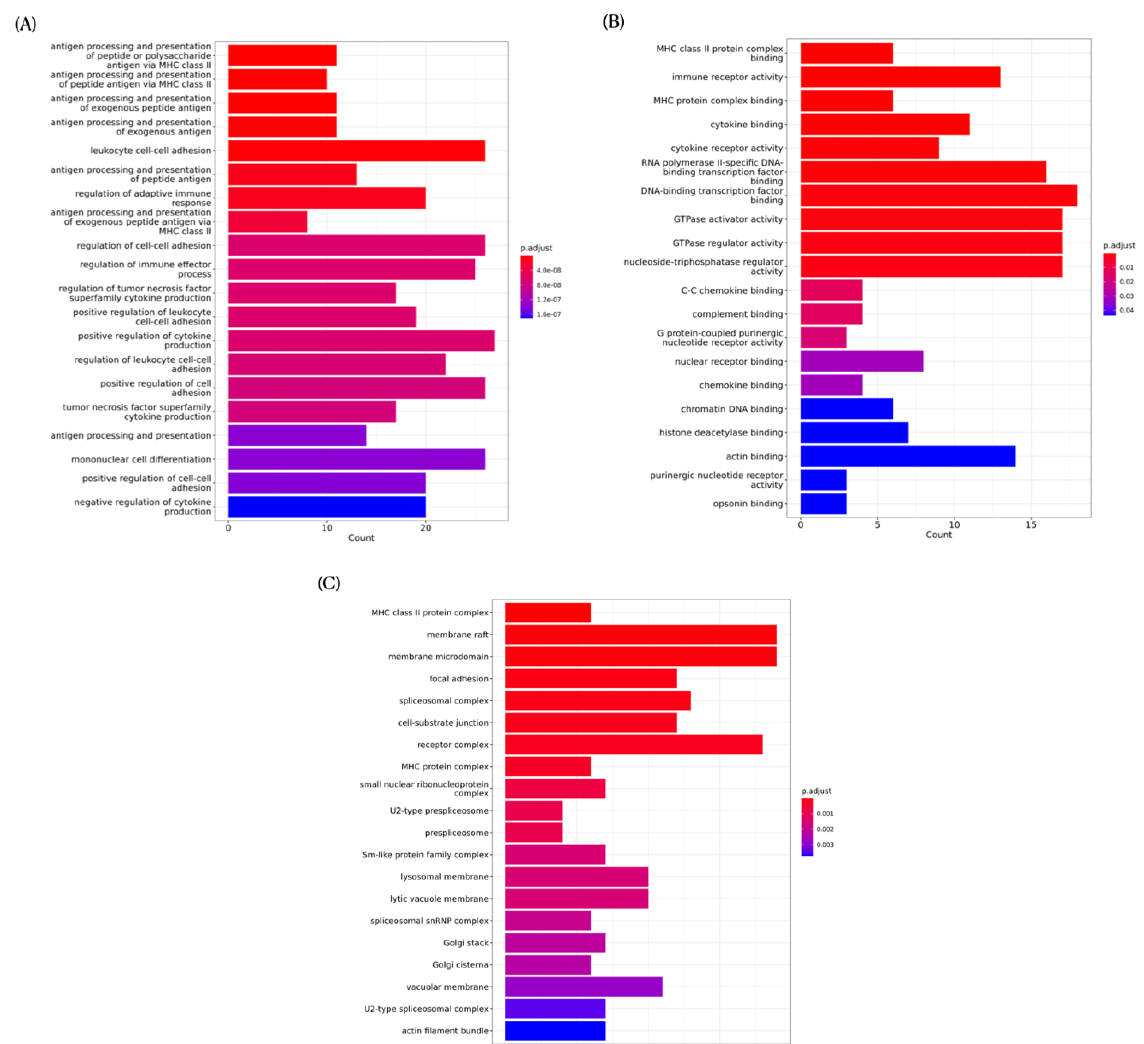
Figure 9. Gene ontology (GO) analysis of EX + RES150 group vs. NC group. ( A ) GO analysis of biological process pathways for EX + RES150 group vs. EX group; ( B ) GO analysis of molecular function pathways for EX + RES150 group vs. EX group; ( C ) GO analysis of cellular component pathways for EX + RES150 group vs. EX group.